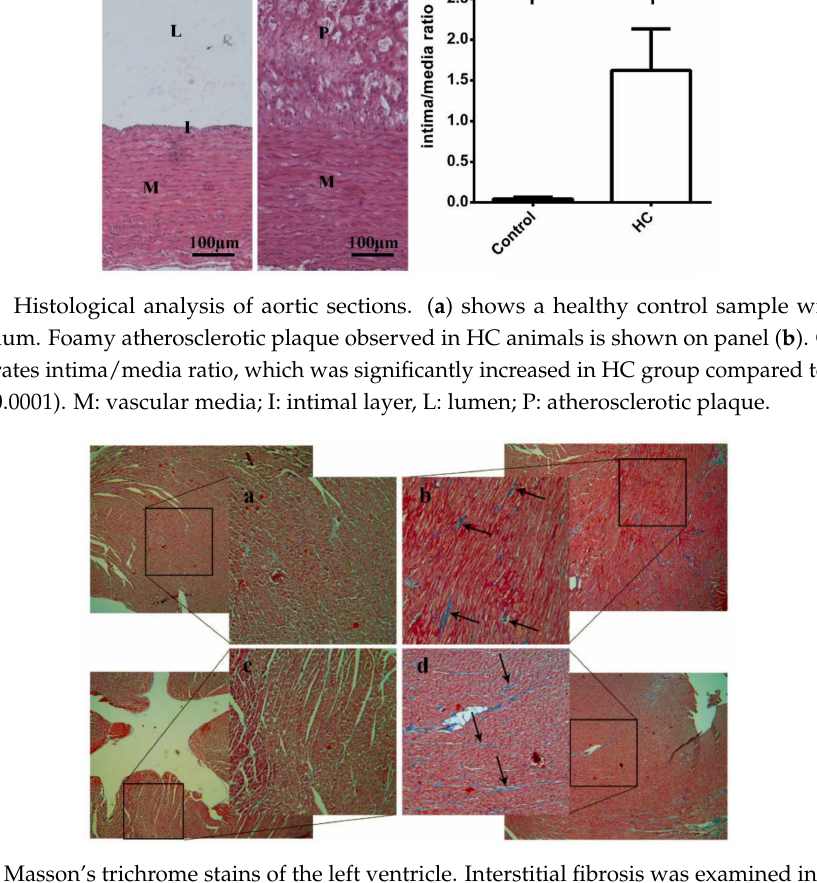
Figure 3. Masson’s trichrome stains of the left ventricle. Interstitial fibrosis was examined in different regions of the myocardial tissue. ( a , b ) are from the midline of the ventricle, ( c , d ) from the apical region. HC samples ( b , d ) show blue fibrotic lines (arrows), while Controls ( a , c ) do not. 40 × (outer pictures) and 100 × (inner pictures)